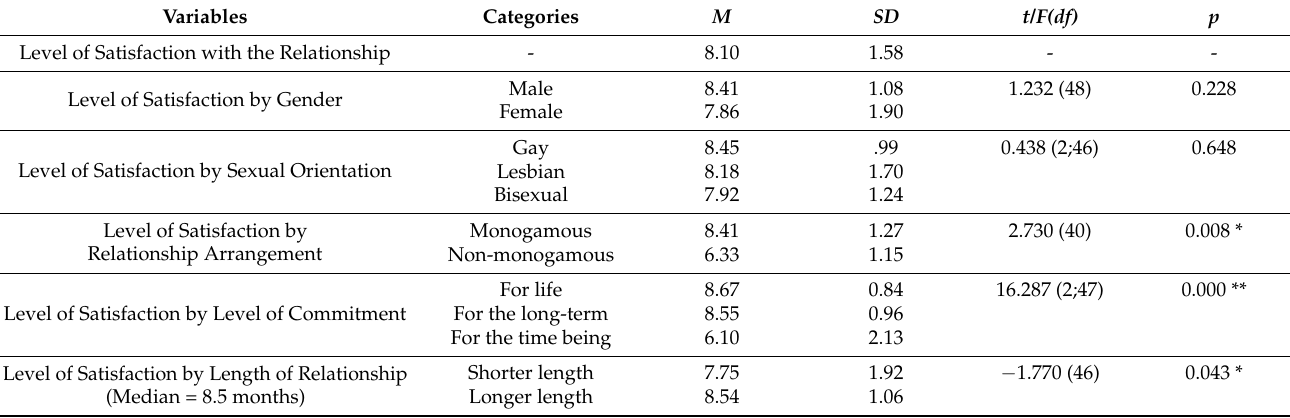
Table 3. Results for Levels of Satisfaction Across Comparison